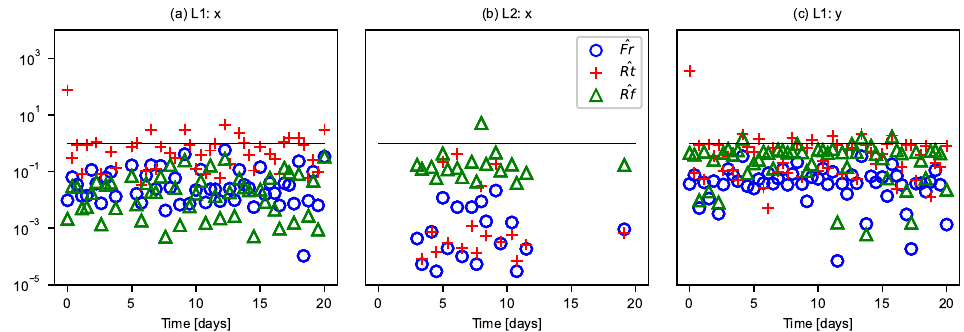
Figure 12. Time-varying numerical dimensionless number at monitoring locations L1 and L2. To keep the figure succinct, the output interval is set to 9